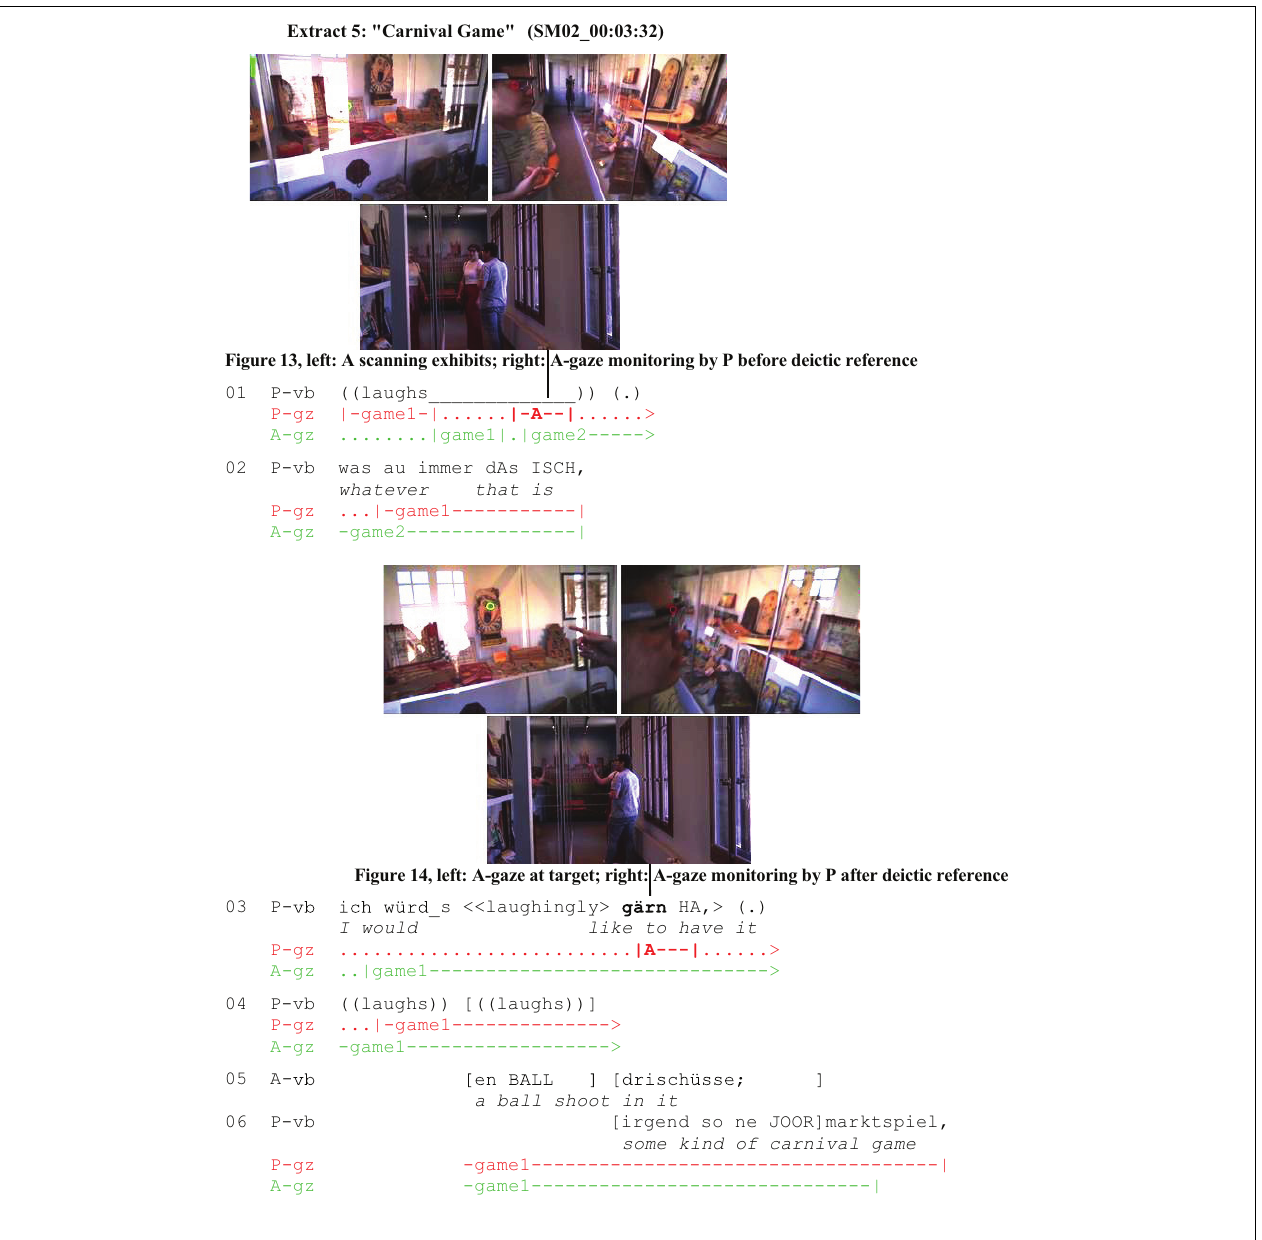
Figure 13, left: A scanning exhibits; right: A-gaze monitoring by P before deictic reference